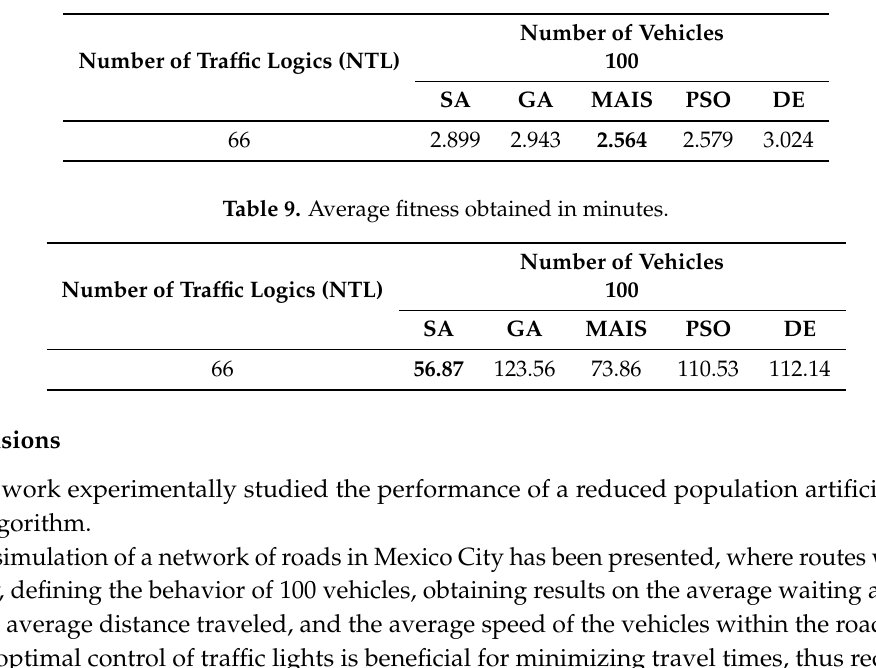
Table 8. Average fitness value obtained by the algorithms.